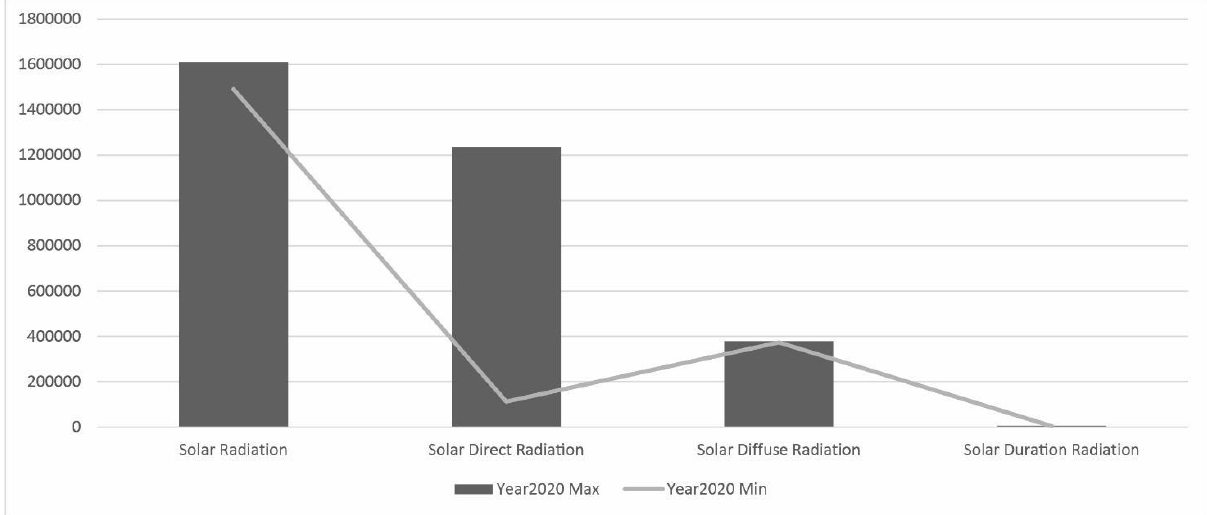
Figure 8- Comparison of the amount of annual radiation in point cloud method